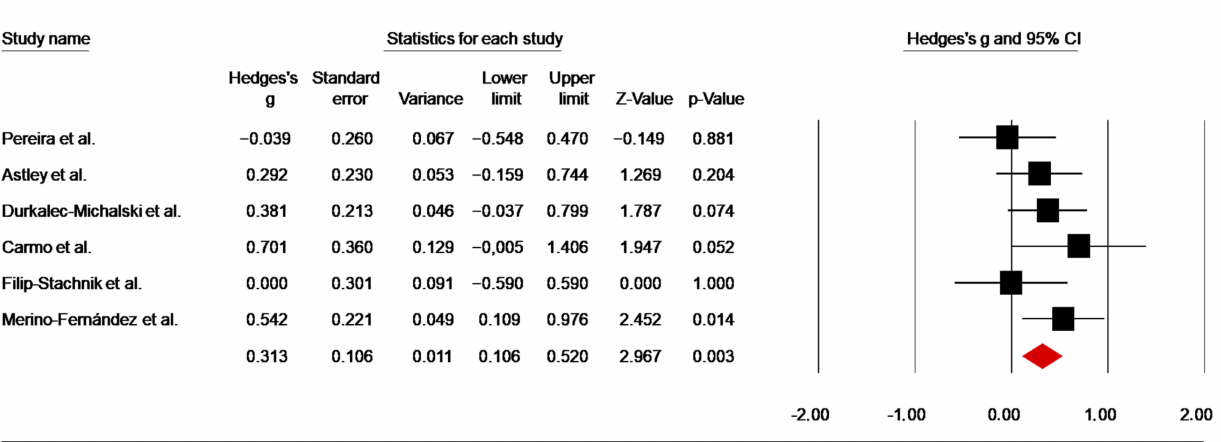
Figure 9. Forest plot of the effect of caffeine intake on HR final [45,47,50,51,55,57]. HR 1